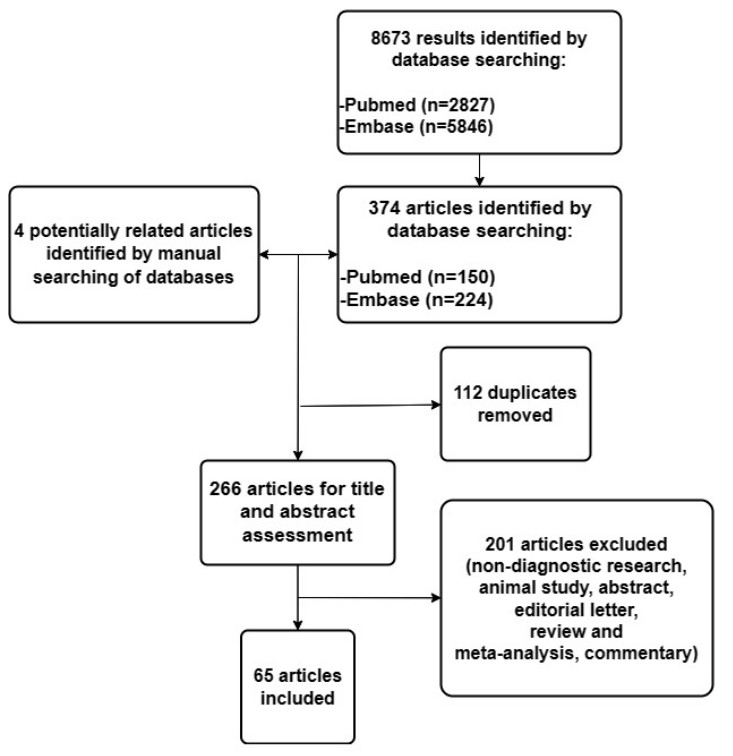
Figure 1. Flow diagram of the literature search and study selection process.